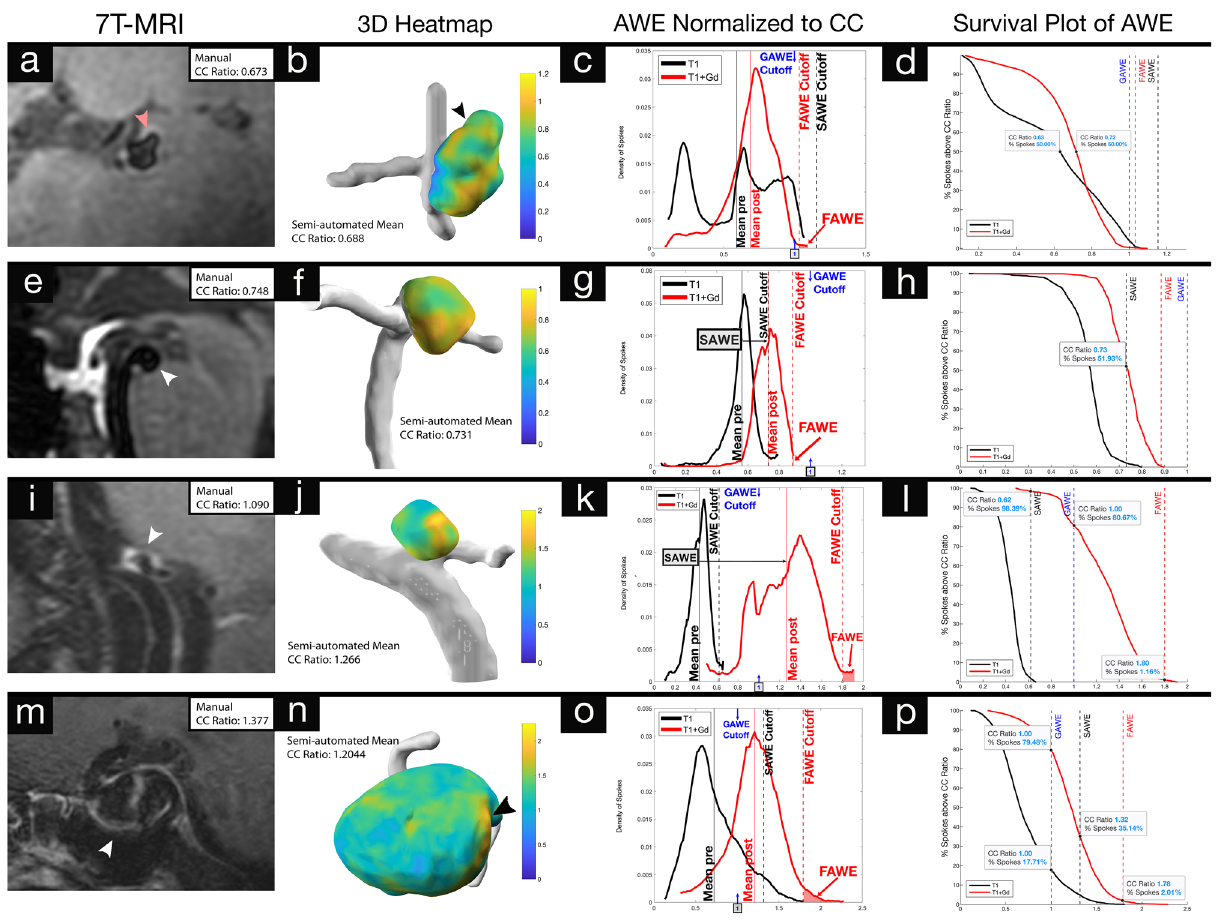
Figure 5. 3D-Heatmaps generated from 7T-MRI T1 + Gd images provide comprehensive topographic views of AWE while histograms and survival plots quantify dynamic changes in AWE before and after contrast administration: specific to each aneurysm (SAWE), against generalized thresholds for enhancement (GAWE) and identifies regions of focal AWE (FAWE). ( a – d ) An M2 aneurysm with a daughter sac (red arrowhead) appears enhancing on 2D-views ( a ). The 3D-Heatmap ( b ) shows heterogeneity in AWE. Histogram analysis ( c ) establishes thresholds for SAWE based on pre-contrast AWE distribution, GAWE (CC ratio ≥ 1, blue arrow) and FAWE based on post-contrast AWE distribution. 50% of spokes had a CC ratio > 0.72 in the T1 + Gd reconstruction compared to 0.63 in the T1 reconstruction, indicating a marginal level of enhancement